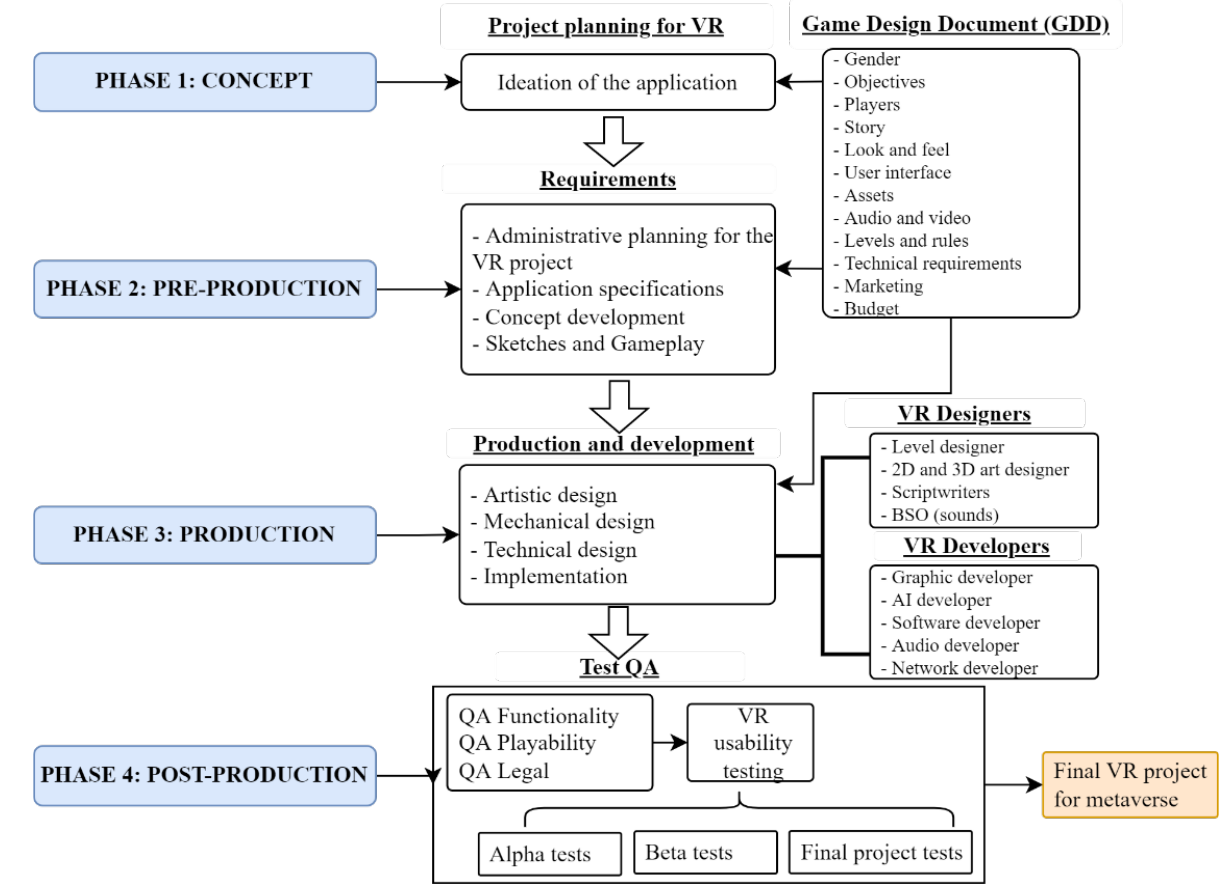
Figure 2. VR development methodology.